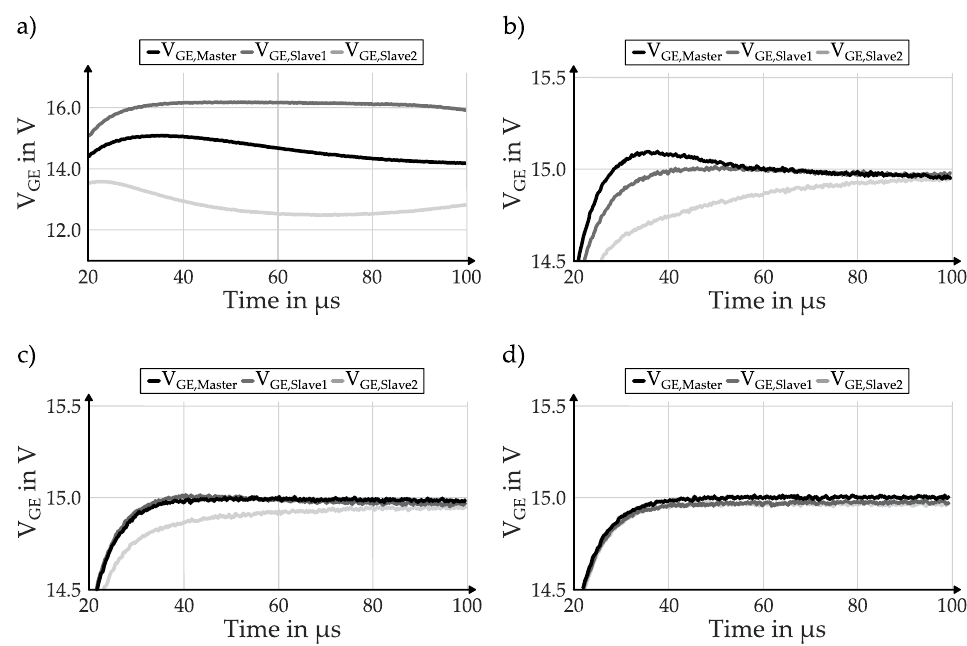
Figure 14. Experimental results of the gate-emitter voltage ( V GE ) of three PEBC modules of one PEBC module package during switch-on operation of IGBTs for the investigated interconnection designs ( a – d ) as presented in Figure 12. Note: Ordinate-scale in ( a ) differs from ordinate- scales in ( b – d ).